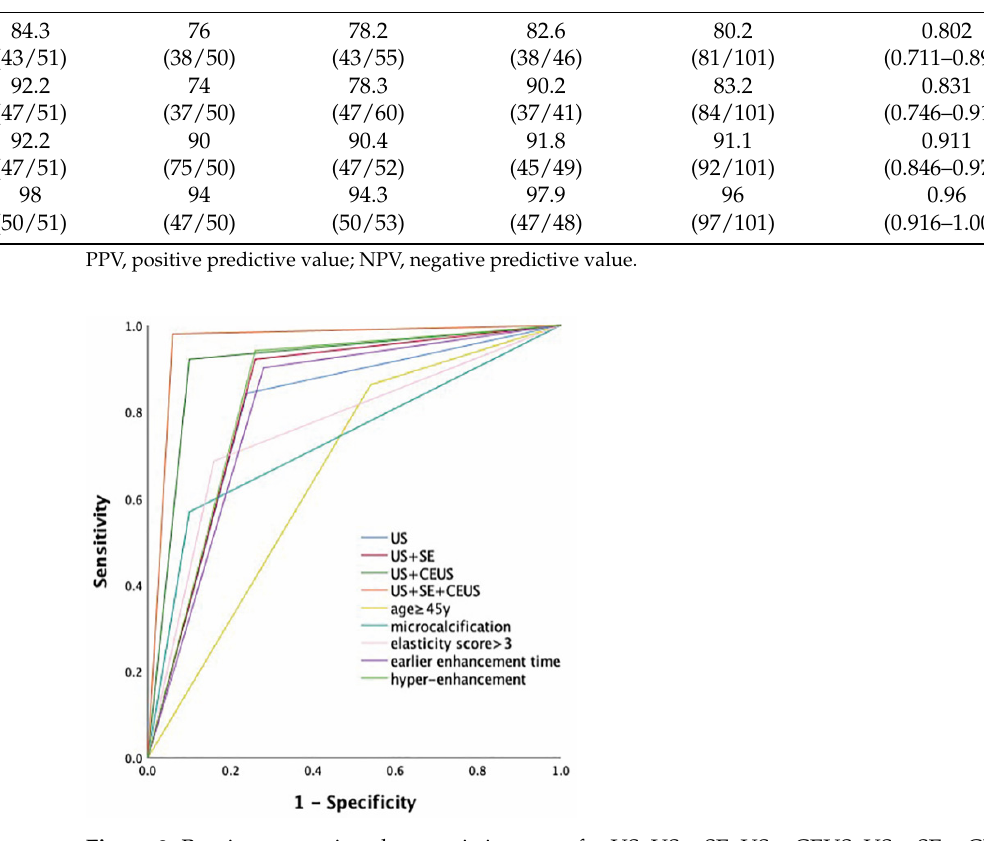
Figure 3. Receiver operating characteristic curves for US, US + SE, US + CEUS, US + SE + CEUS and each of the independent risk factors. The AUC was 0.802 for US, 0.831 for US + SE, 0.911 for US + CEUS and 0.960 for US + SE + CEUS; The AUC was 0.661 for age ≥ 45 y, 0.734 for mi- crocalcifications, 0.763 for elasticity score >3, 0.811 for earlier enhancement time and 0.841 for